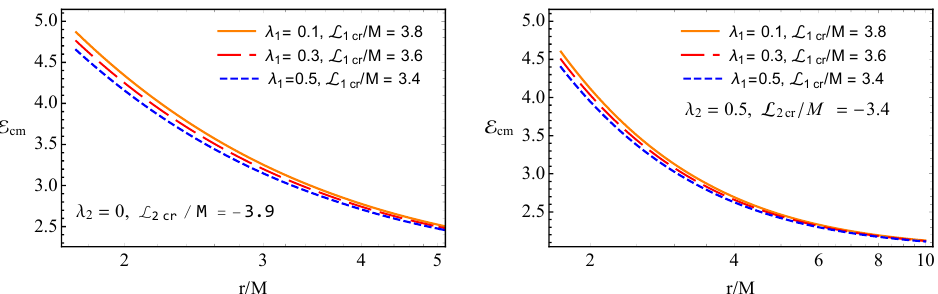
Figure 16. The same figure with Figure 14 but for collisions of magnetically charged particles with (i) neutral particles ( left panel), and (ii) magnetically charged particles ( right panel). Here, we choose α / M 2 = 0.2 and g / M = 0.4.